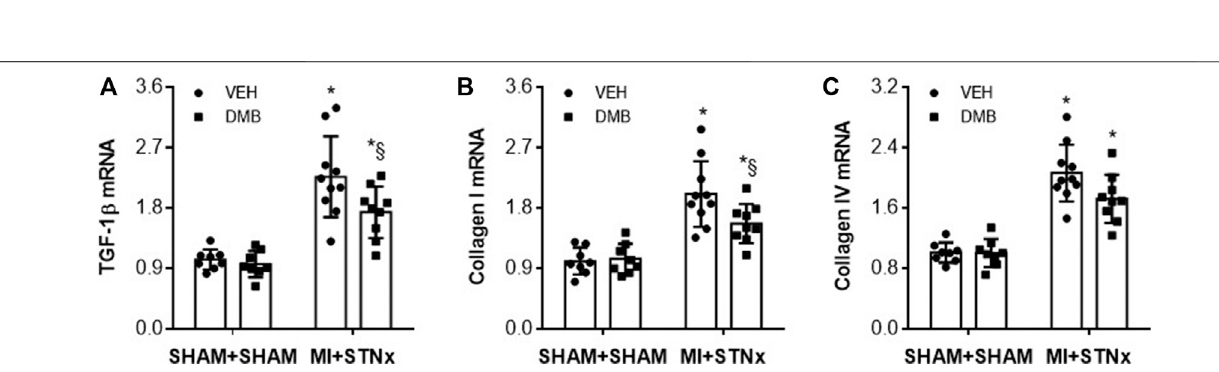
Frontiers in Pharmacology |